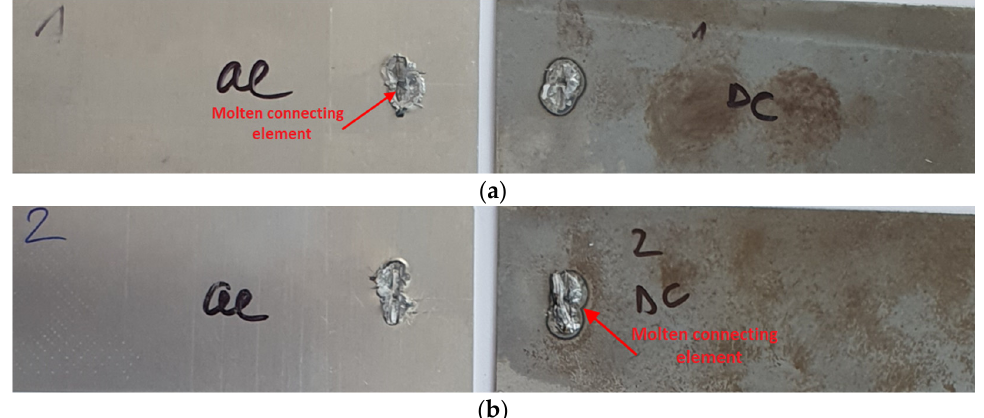
Figure 7. Fracture surfaces of some Al-DC test joints after tensile shear test: ( a ) sample 1 and ( b ) sample 2.